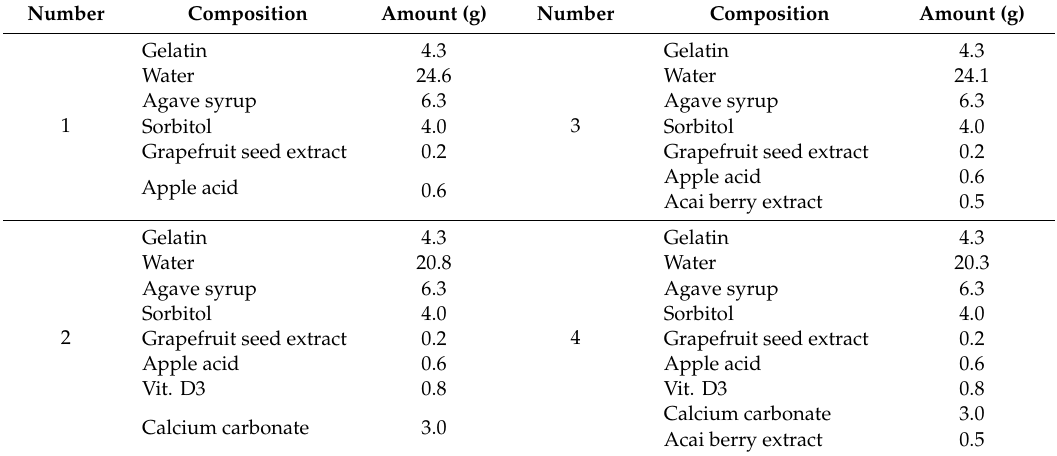
Table 4. Di ff erent gummy bear